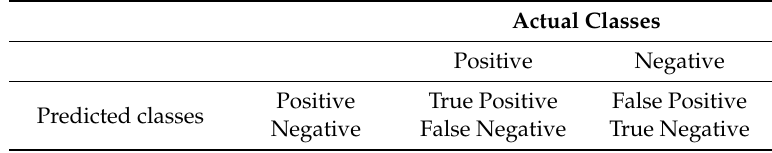
Table 3. Confusion